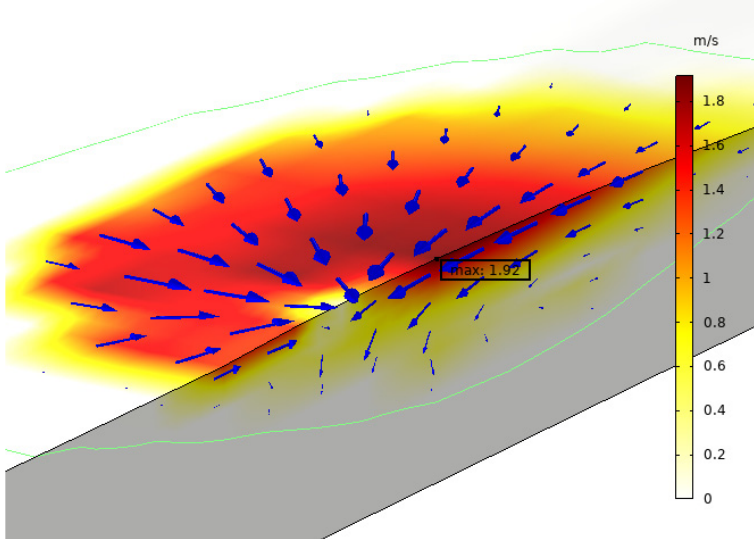
Figure 8. Flow field and stream lines in the molten pool calculated under condition of the alternating magnetic field. The green line marks the liquid–solid interface where temperature is equal to the melting temperature. The vector length is proportional to logarithm of the velocity magnitude log (|𝑣|) . In Figure 9, the distributions of temperature and temperature gradient are simulated under the alternating magnetic field. The calculated maximum temperature at the melt surface attains 2739 K with the temperature gradient 𝐺 (cid:3021) ~4.5 × 10 (cid:2875) K/m. The simulations carried without the external magnetic field result in the values 2744 K and 4.0 × 10 (cid:2875) K/m correspondingly. The obtained values evidence that the effect of the alternating magnetic field leads to increase of the temperature gradient between 10 and 15%. The temperature gradient is more sensitive to the external EM field, while convection is less responsive to the magnetic exposure. Therefore, microstructure modification in the annealed stainless steel is possible under condition of its simultaneous laser processing and EM treatment with EMAT. This conclusion follows from the theory of directional solidification [39], where 𝜐 and 𝐺 (cid:3021) are the control parameters that select the microstructure. The experi- mental confirmation of such an effect found in our study is presented above in the “Ex- perimental Methodology and Microstructure Assessment” Section. Since no changes in the shape of the molten pool were observed, it is assumed that the change in the grain size distribution is caused by the alignment (temporal stabilization) of the velocity field near the solidification front.